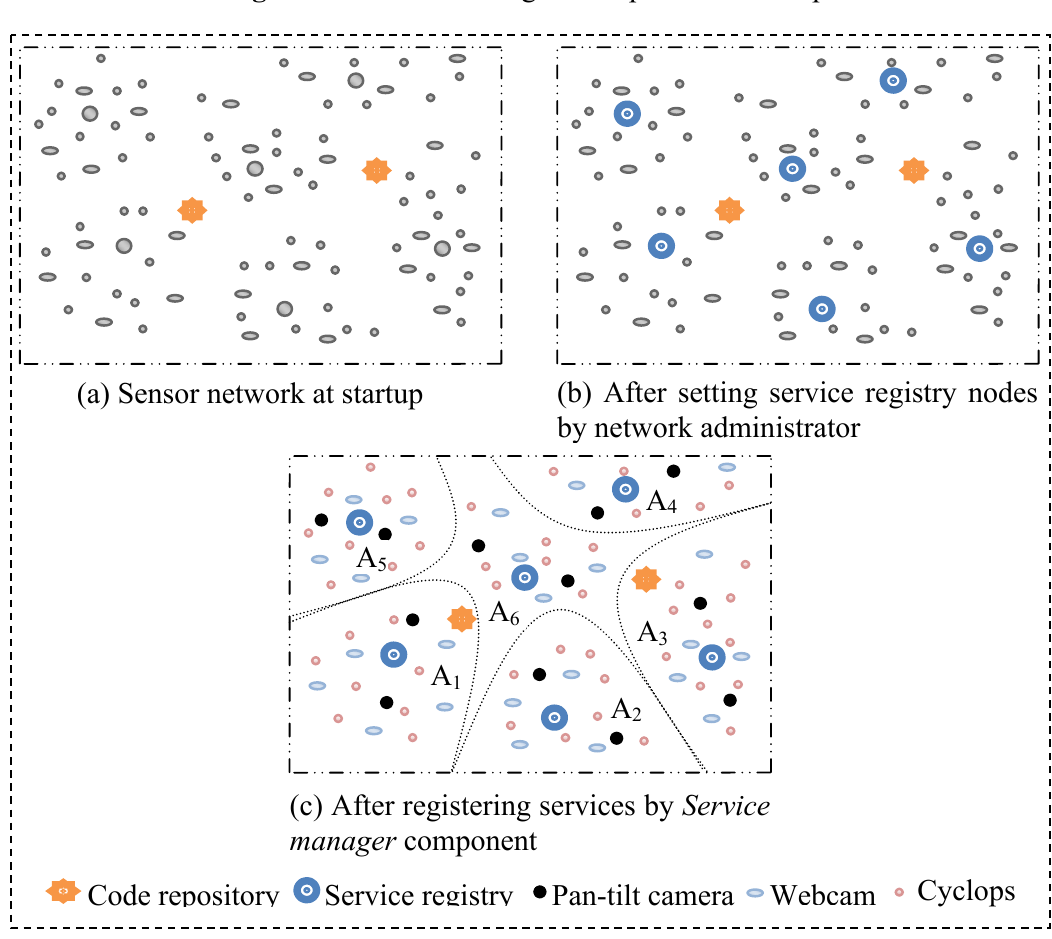
Figure 3. Network configuration phases at